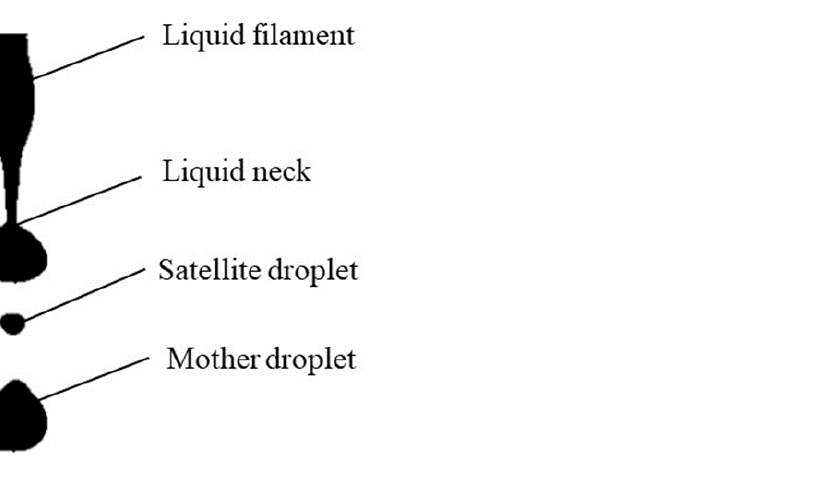
Figure 3. Snapshot of the pinch-off of a deionized water filament and the generation of satellite